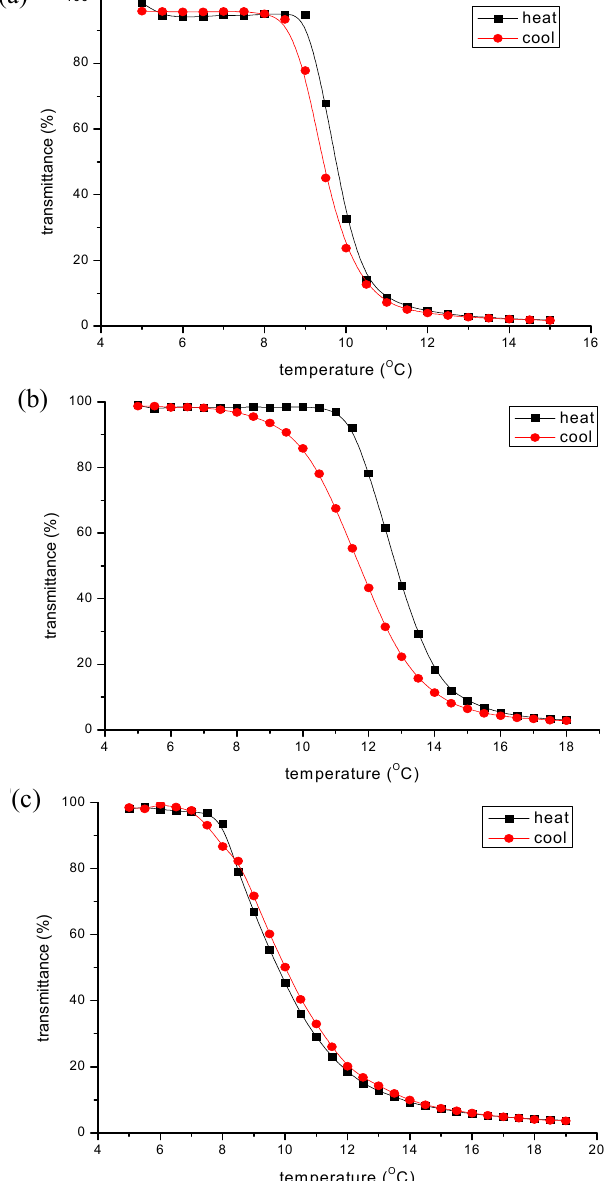
Figure 1. Plot of transmittance as a function of temperature measured for polyester aqueous solution (0.5 wt %) at a heating/cooling rate of 0.5 °C·min − 1 : Black dots, heating curve; red dots, cooling curve. ( a ) Polyester 3a ; ( b ) Polyester 3b ; and ( c ) Polyester 3c